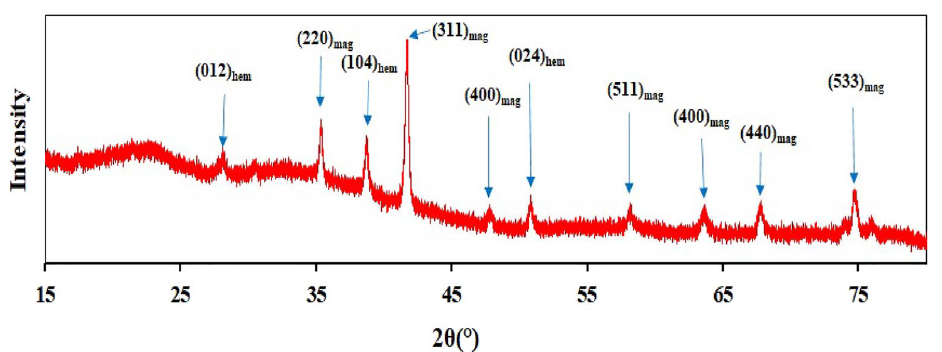
Figure 6. XRD spectrum of the prepared HPW@Fe 3 O 4 –Al 2 O 3 –CS–CG